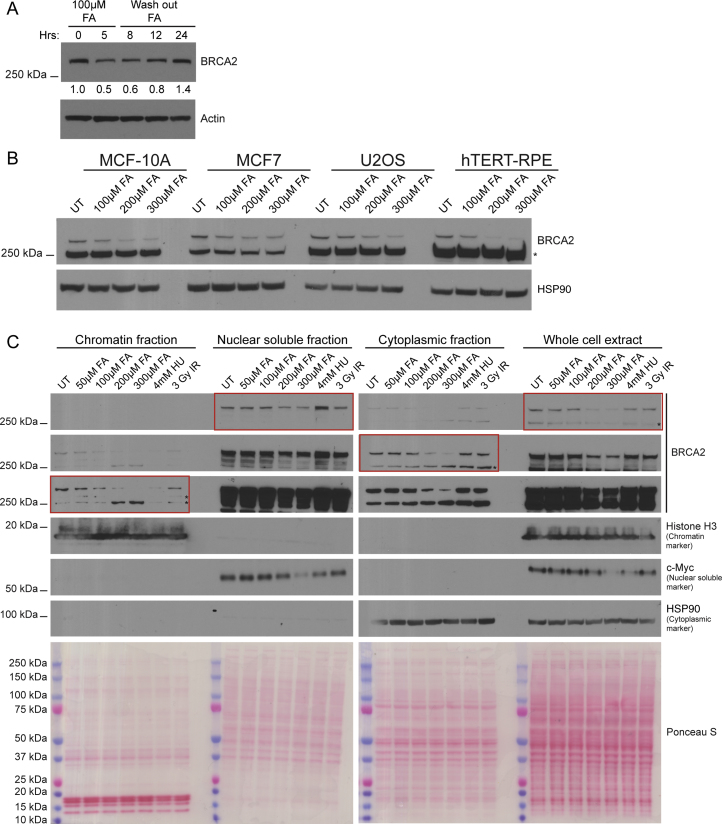
Related to Figure 3(A) BRCA2 protein levels at the indicated time points in wild-type HeLa Kyoto cells. Cells were treated with 100μM FA for 5h, washed and harvested for western blotting at the indicated time points. Numbers below the BRCA2 blot represent densitometric measurements of BRCA2 band intensities normalized to loading control and the 0h time point.(B) BRCA2 protein levels in cells from four different cell lines after treatment with the increasing doses of formaldehyde for 5h.(C) BRCA2 protein levels in different cellular fractions of wild-type HeLa Kyoto cells after exposure to the indicated treatments for 3h. Different exposures of BRCA2 are shown, with red boxes highlighting the appropriate exposures for the various fractions.